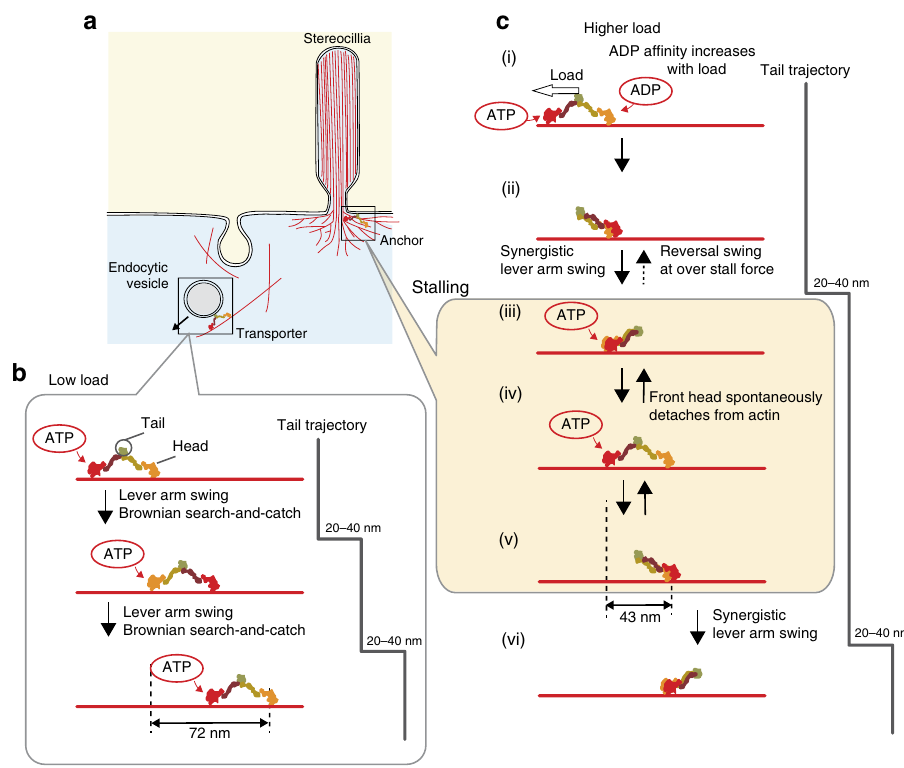
Figure 5 | Force-dependent transport and anchoring mechanisms of myosin VI. ( a ) Examples of myosin VI transport and anchor function in cells. Endocytic vesicle transport and the maintenance of stereocillia are shown as examples. ( b ) Hand-over-hand motion is used for transport, which